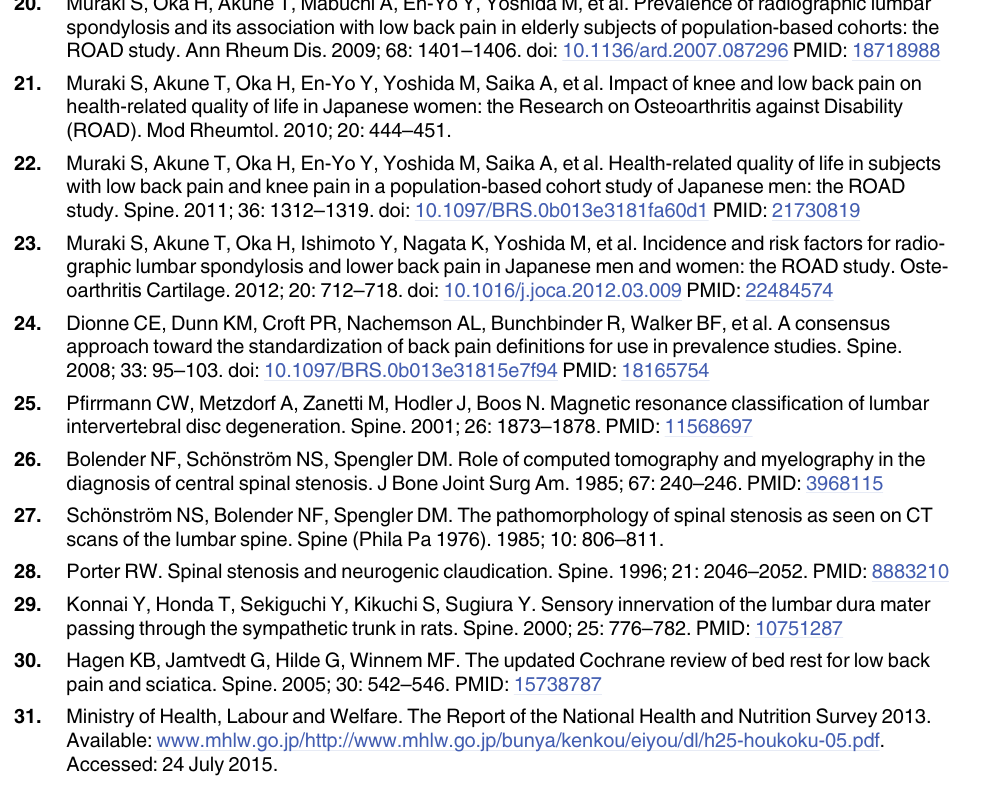
PLOS ONE | DOI:10.1371/journal.pone.0160002 August 3,